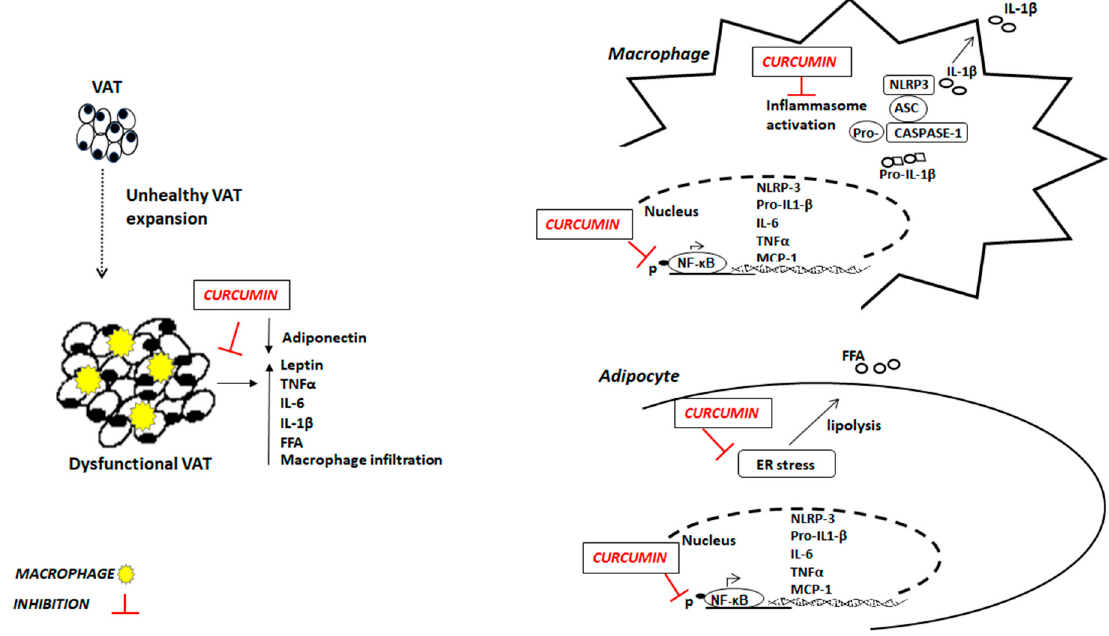
Figure 1. Potential anti-inflammatory mechanisms of curcumin in obesity. VAT: visceral adipose tissue; FFA: free fatty acids; TNF α : tumor necrosis factor α ; IL-6: interleukin 6; IL-1 β : interleukin β ; ER: endoplasmic reticulum; NF- κ B: Nuclear transcriptor factor kappa B; MCP-1: Monocyte chemoattractant protein-1; NLRP-3: nod-like receptor pyrin domain-containing